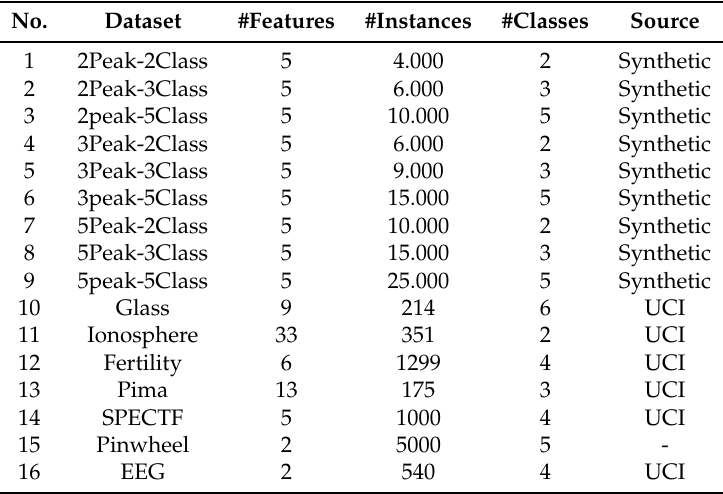
Table 1. Detail of